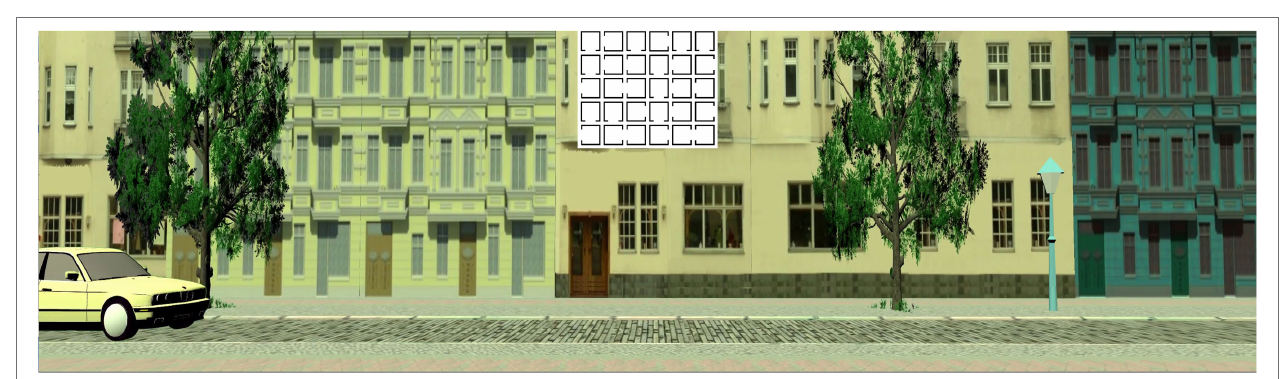
FIGURE 3 | The visual task along with the stop task, with one car approaching from the left